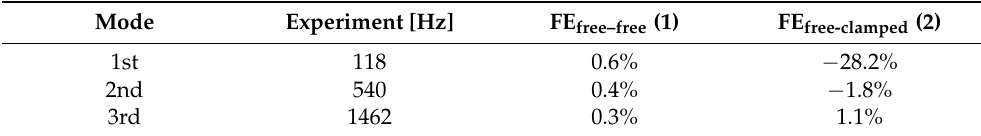
Figure 4. Two numerical model finite element results compared to experiments for the eigenfrequencies related to the first three bending modes. Experiment: contact-free measurement setup Figure 1a. Table 2. Averaged relative deviation ε from the finite element models to the experiment for the eigen- frequencies of the first three bending modes. FE free–free ( 1 ): reference model without simplifications. FE free-clamped and ( 2 ): simplified finite element model of the beam with ideal-rigid clamping. Mode Experiment